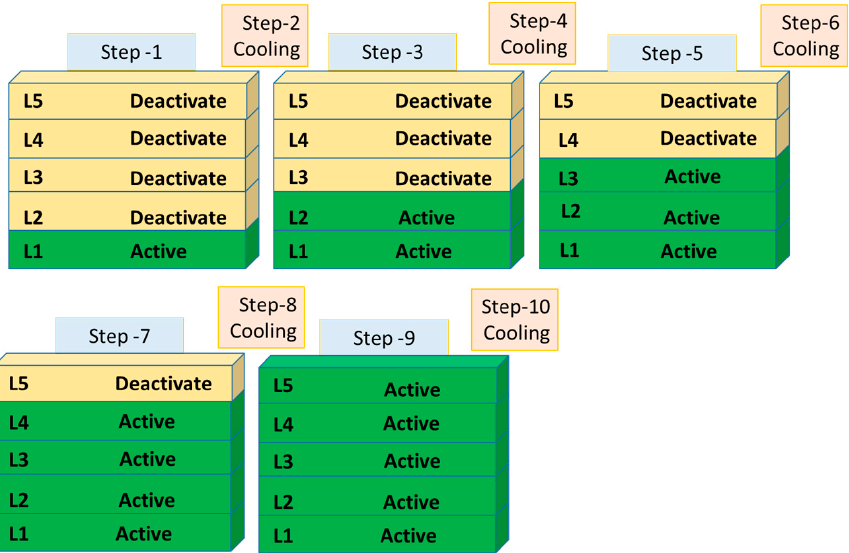
Figure 6. Using model change to activate the deactivated layers during the EBM process. Table 3. Model transformation phases.